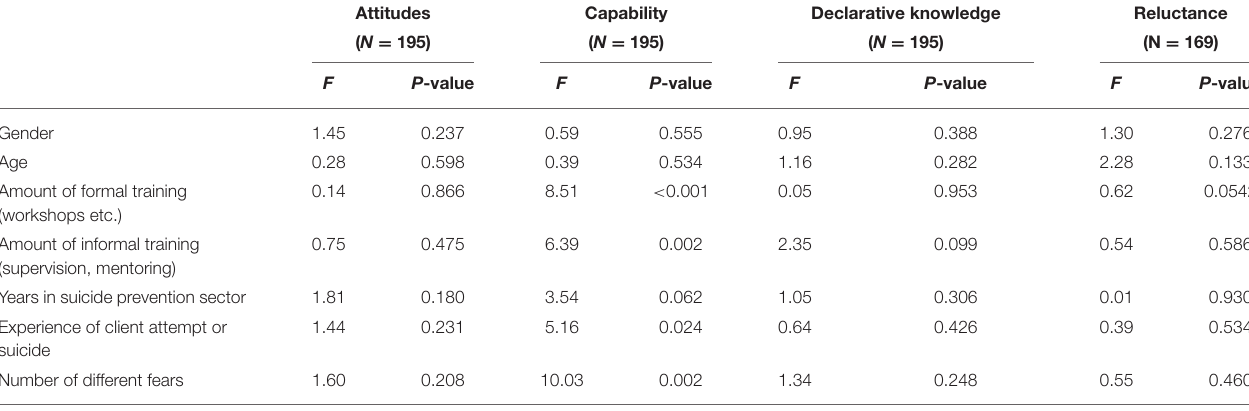
TABLE 4 | Fixed effect estimates for the predictors of the main outcome measure at baseline (pre-training) from the linear mixed-effects models.